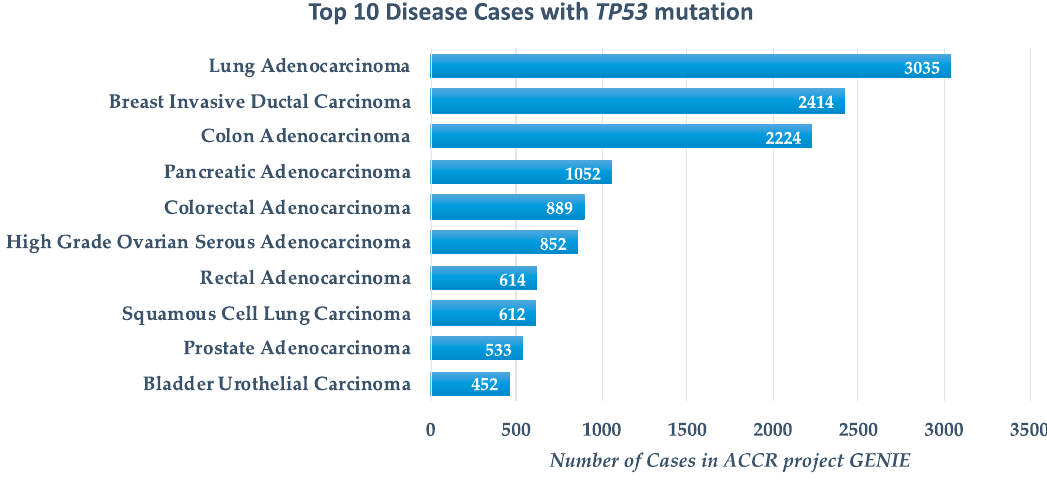
Figure 1. Top 10 disease cases with TP53 mutations, according to the GENIE (Genomics Evidence Neoplasia Information Exchange) project by AACR (American Association for Cancer Research).